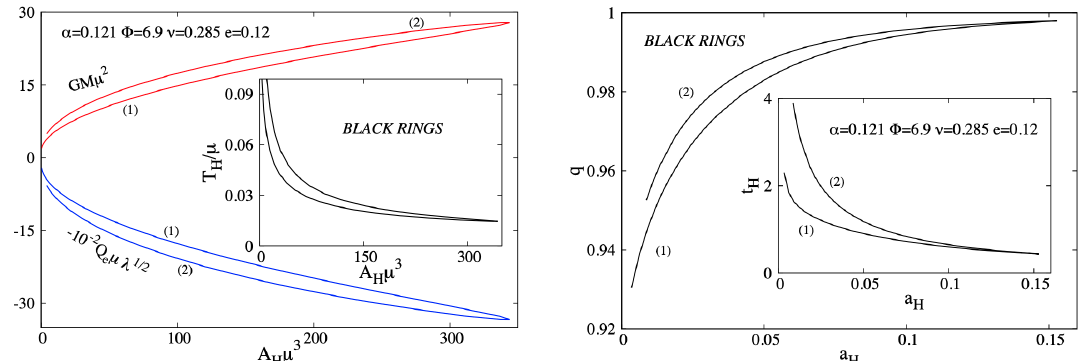
Figure 6 . The mass, electric charge and Hawking temperature of solutions are shown as a function of event horizon area for balanced BR